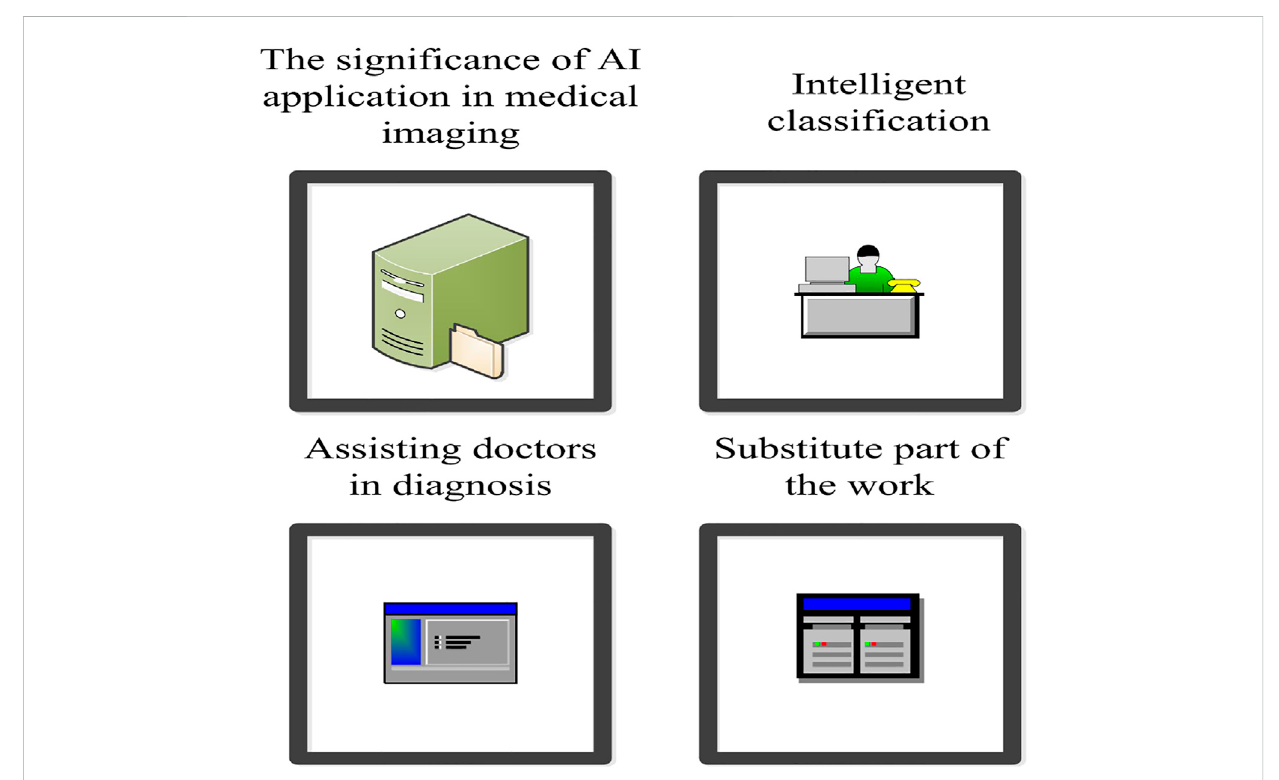
FIGURE 1 Signi fi cance of AI application to medical